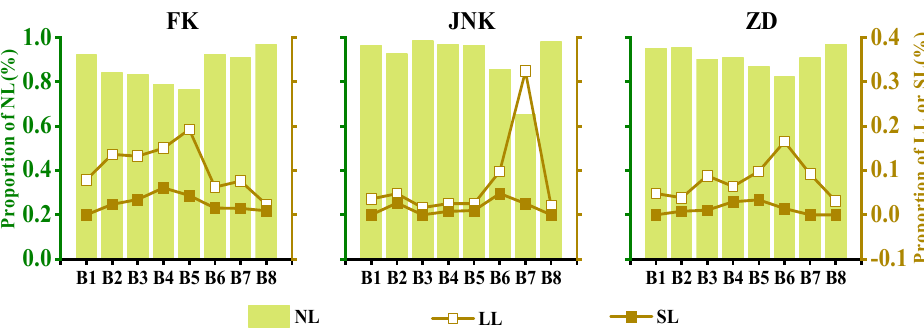
Figure 18. Lodging resistance of three maize varieties sowed at different dates. The histograms show the fraction of NL area, and the two curves show the lodging resistance to LL and SL for the different sowing dates. The fraction of SL is almost zero, and LL mainly occurs in R1, VT, and V14.